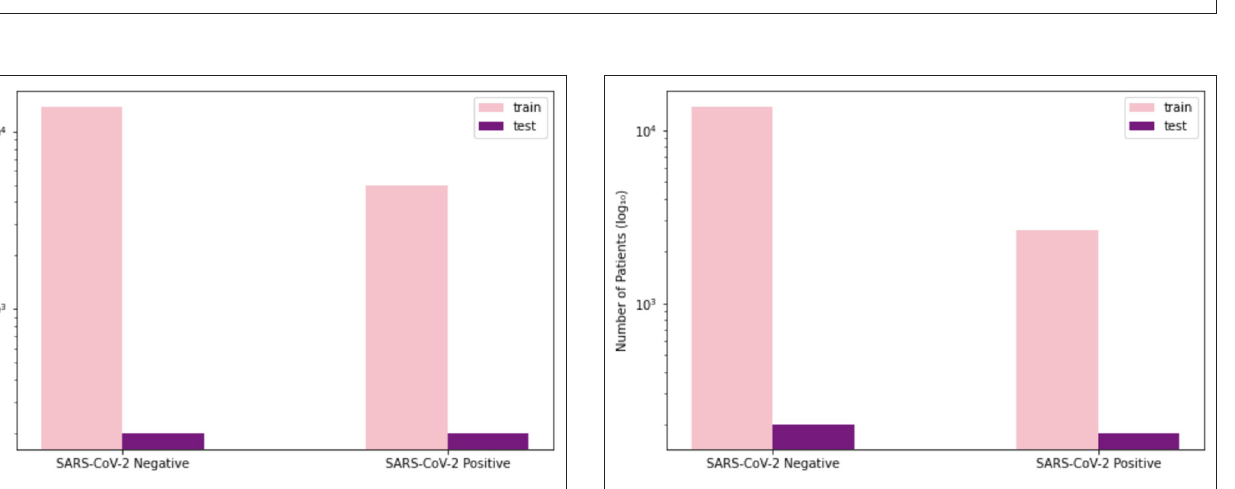
FIGURE 1 | Example chest X-ray images from the benchmark dataset: (1) SARS-CoV-2 negative patient cases and (2) SARS-CoV-2 positive patient cases.